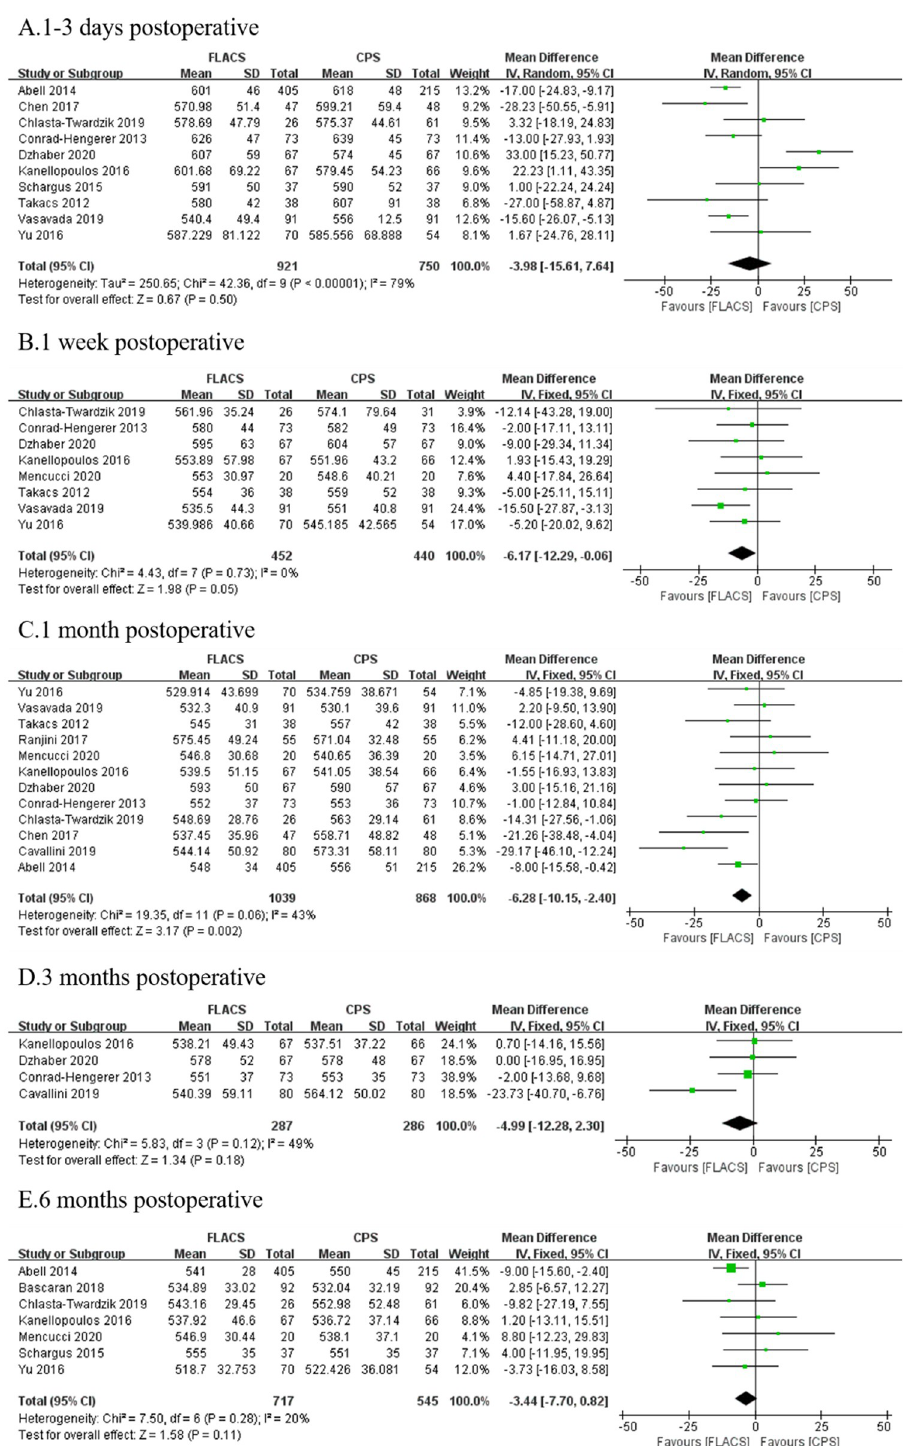
Fig 5. Forest plot of postoperative CCT between FLACS and CPS at A. 1–3 days, B. 1 week, C. 1 month, D. 3 months, and E. 6 months.